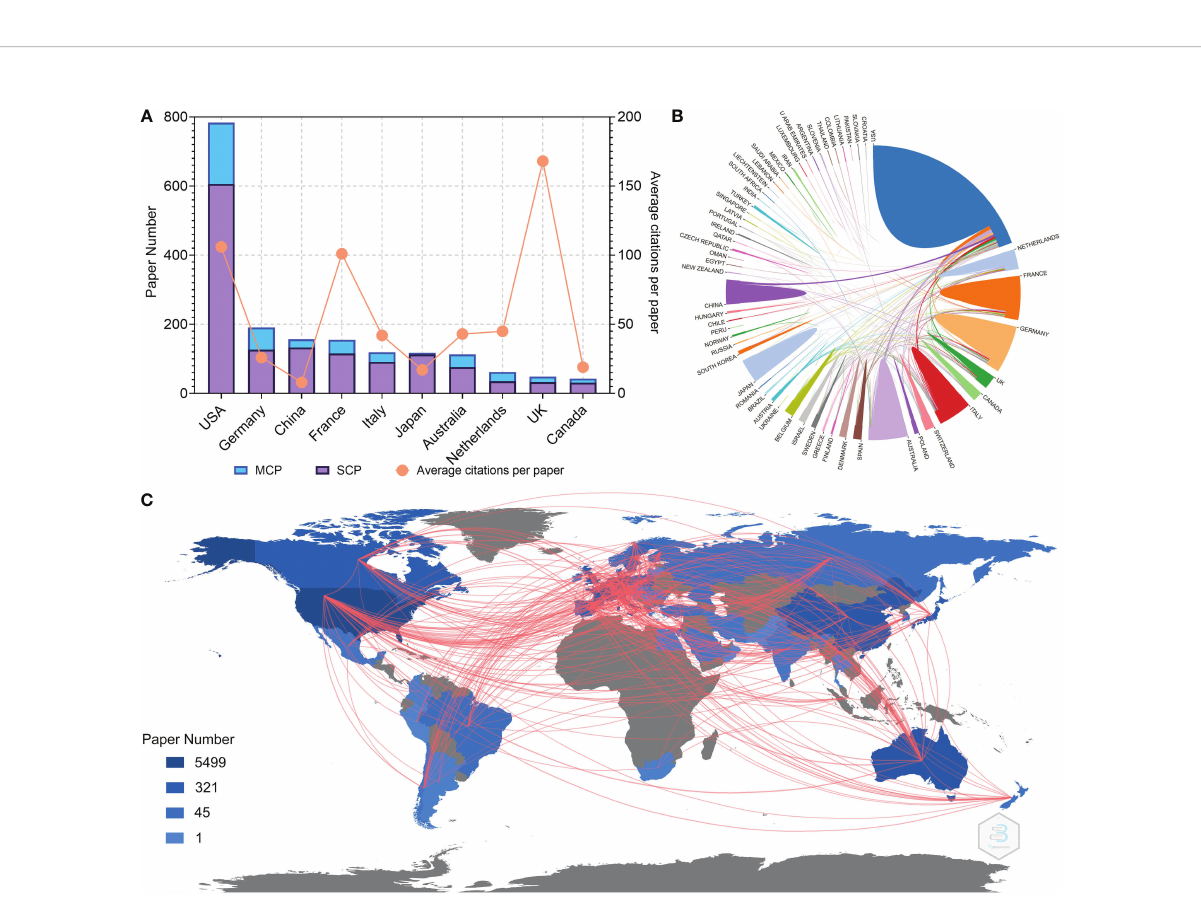
FIGURE 3 (A) Paper number and average citations of corresponding authors ’ countries. MCP, multiple-country publications; SCP, single-country publications. (B) Network mapping of international collaboration. (C) Visualization world map of paper number and collaboration